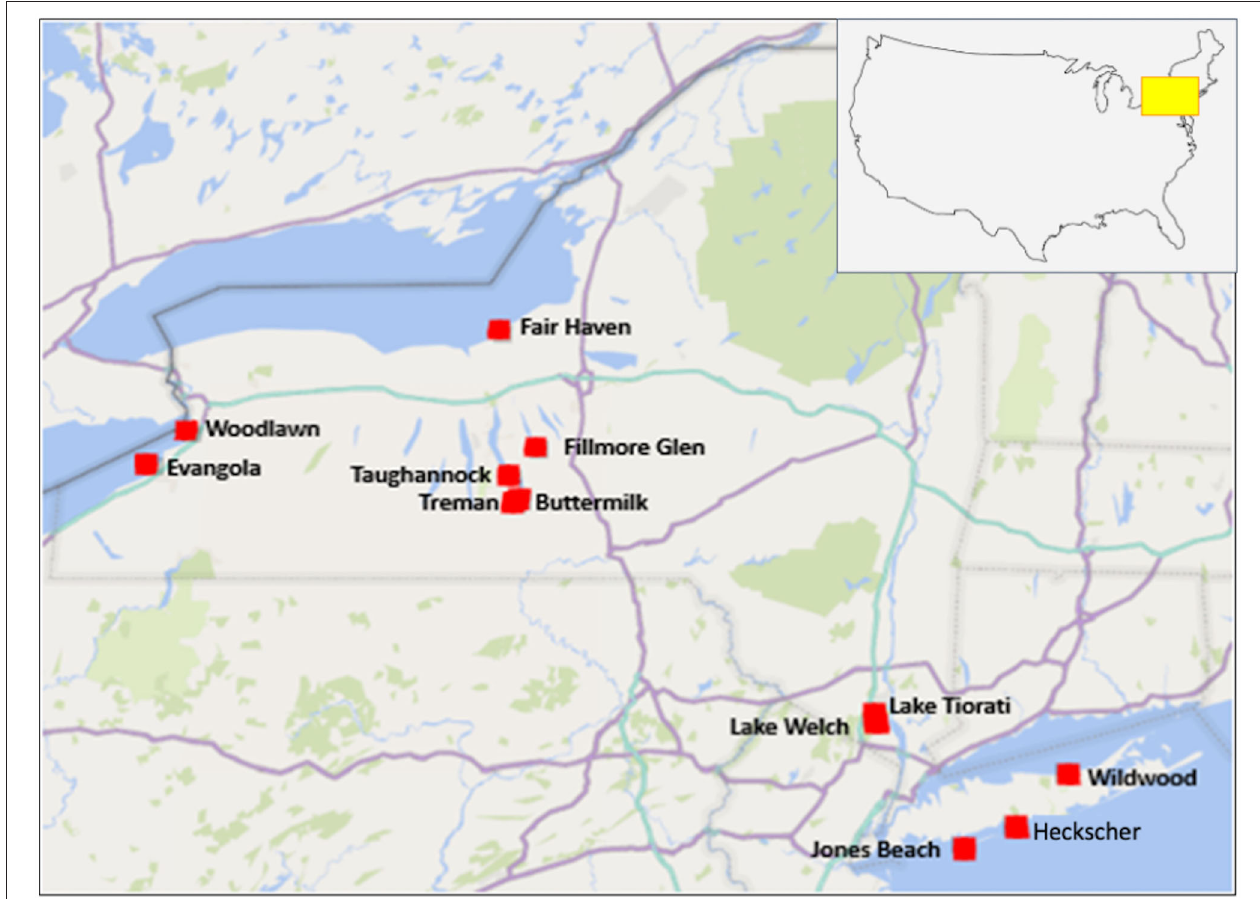
FIGURE 2 | Sampling locations of swimming areas for New York State parks